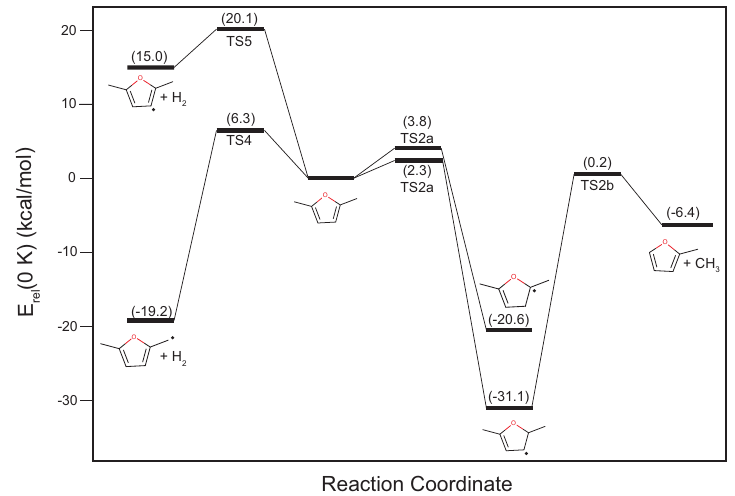
Figure 5. Potential energy diagram for 2,5-DMF + H (adapted from Friese et al.